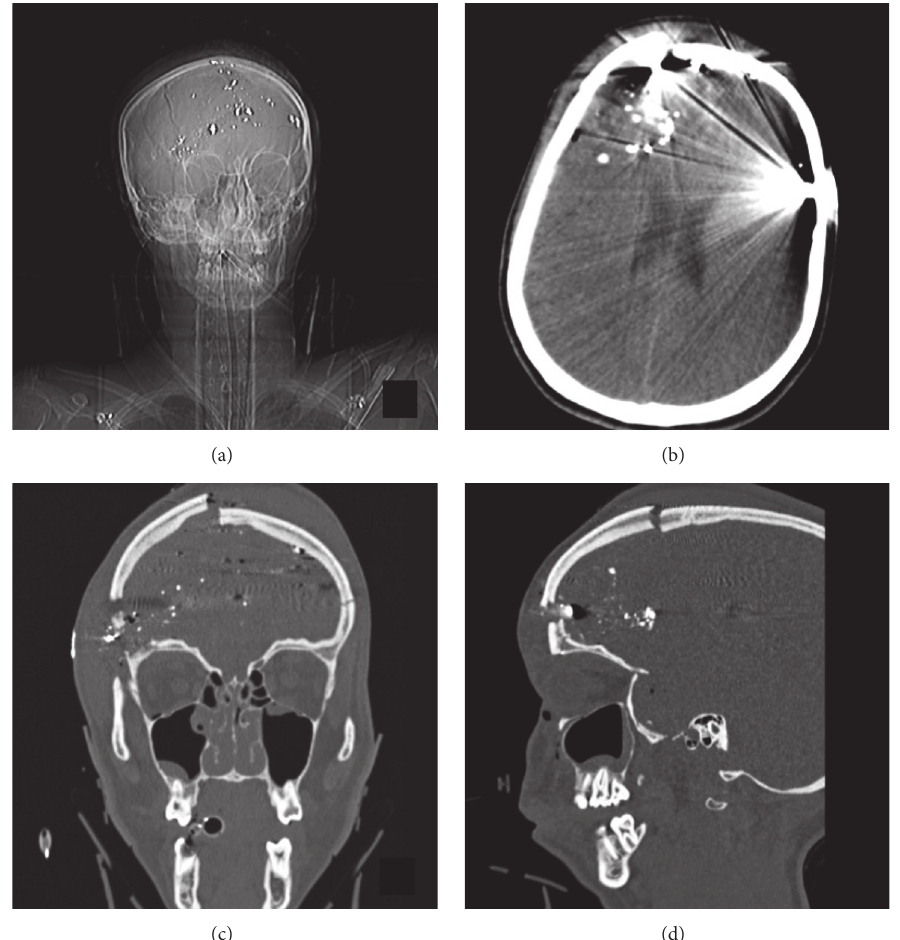
Figure 1: Preoperative computed tomography (CT) of the head and neck. (a) Scout image demonstrating multiple metallic fragments intracranially and in the bifrontal soft tissue and bone. (b) Axial noncontrast CT demonstrating an extensive right frontal skull fracture with intracranial acute blood products including intraparenchymal, subarachnoid, subdural, and epidural components. (c, d) Coronal and sagittal reconstructions demonstrating the entry and exit sites of the bullet and the comminuted displaced free floating right frontal bone